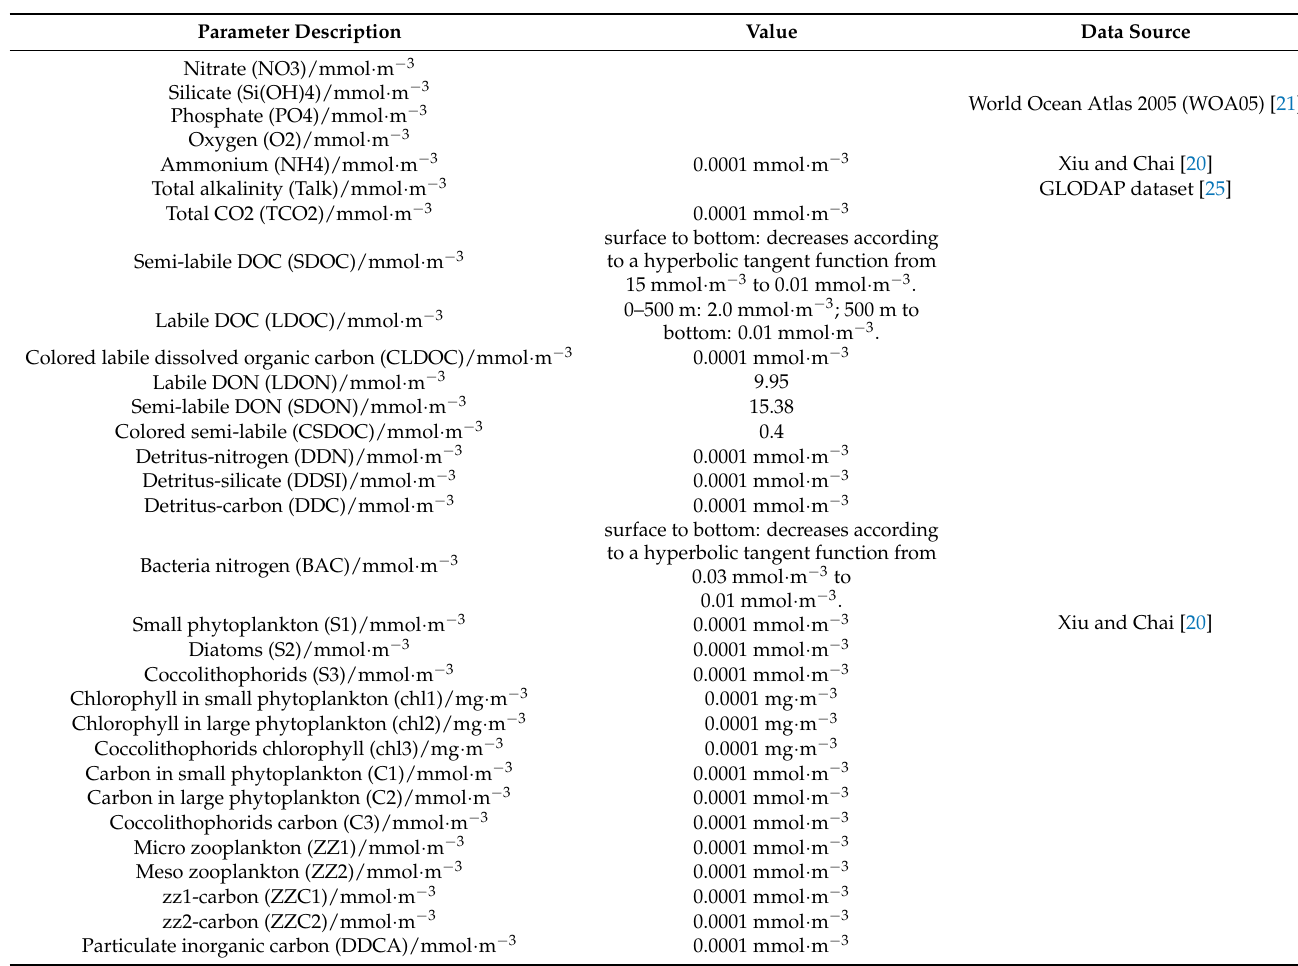
Table 1. The initial conditions for the coupled physical–biogeochemical model for the Yangtze River